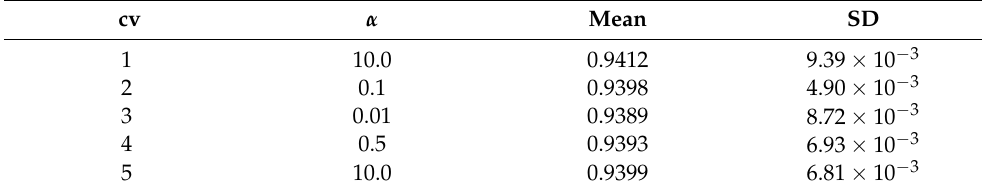
Table 6. Best naive Bayes model by iteration.